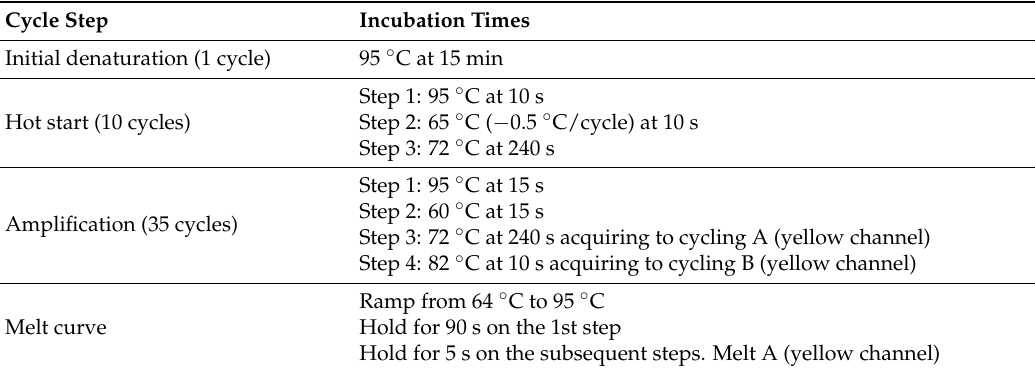
Table 2. Optimized cycling conditions for quantitative polymerase chain reaction